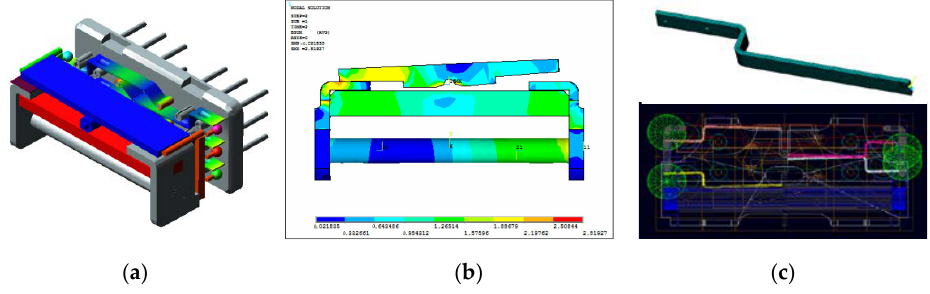
Figure 10. The simulation model of a rotary PMA: ( a ) 3D model of the entire machine; ( b ) electro- magnetic system simulation model; ( c ) contact system simulation model.